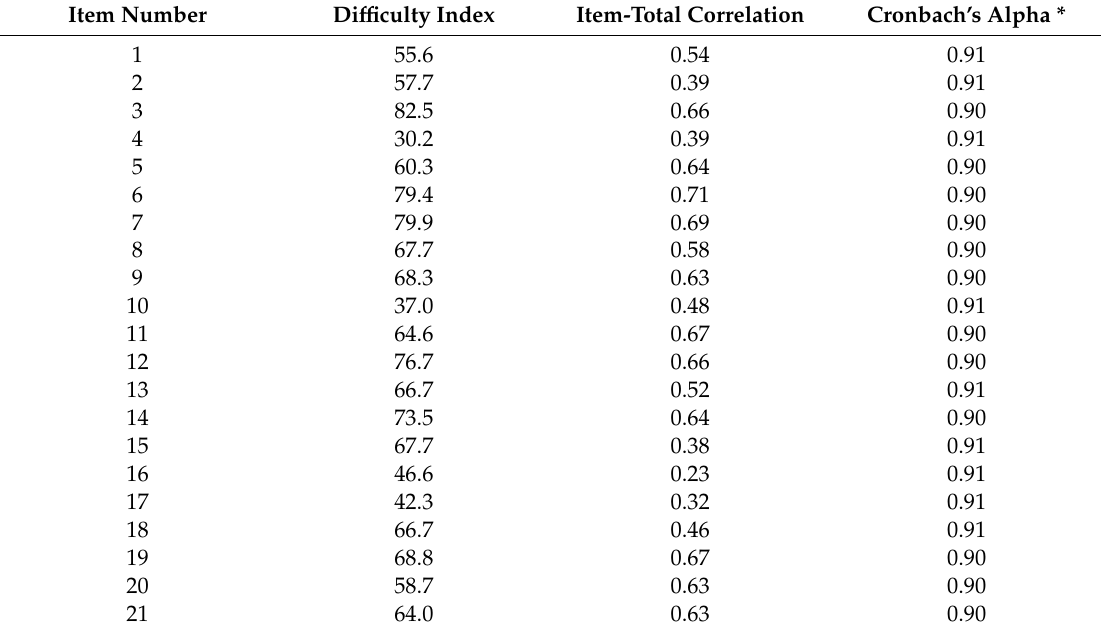
Table 3. Psychometric properties of the AFKAT by